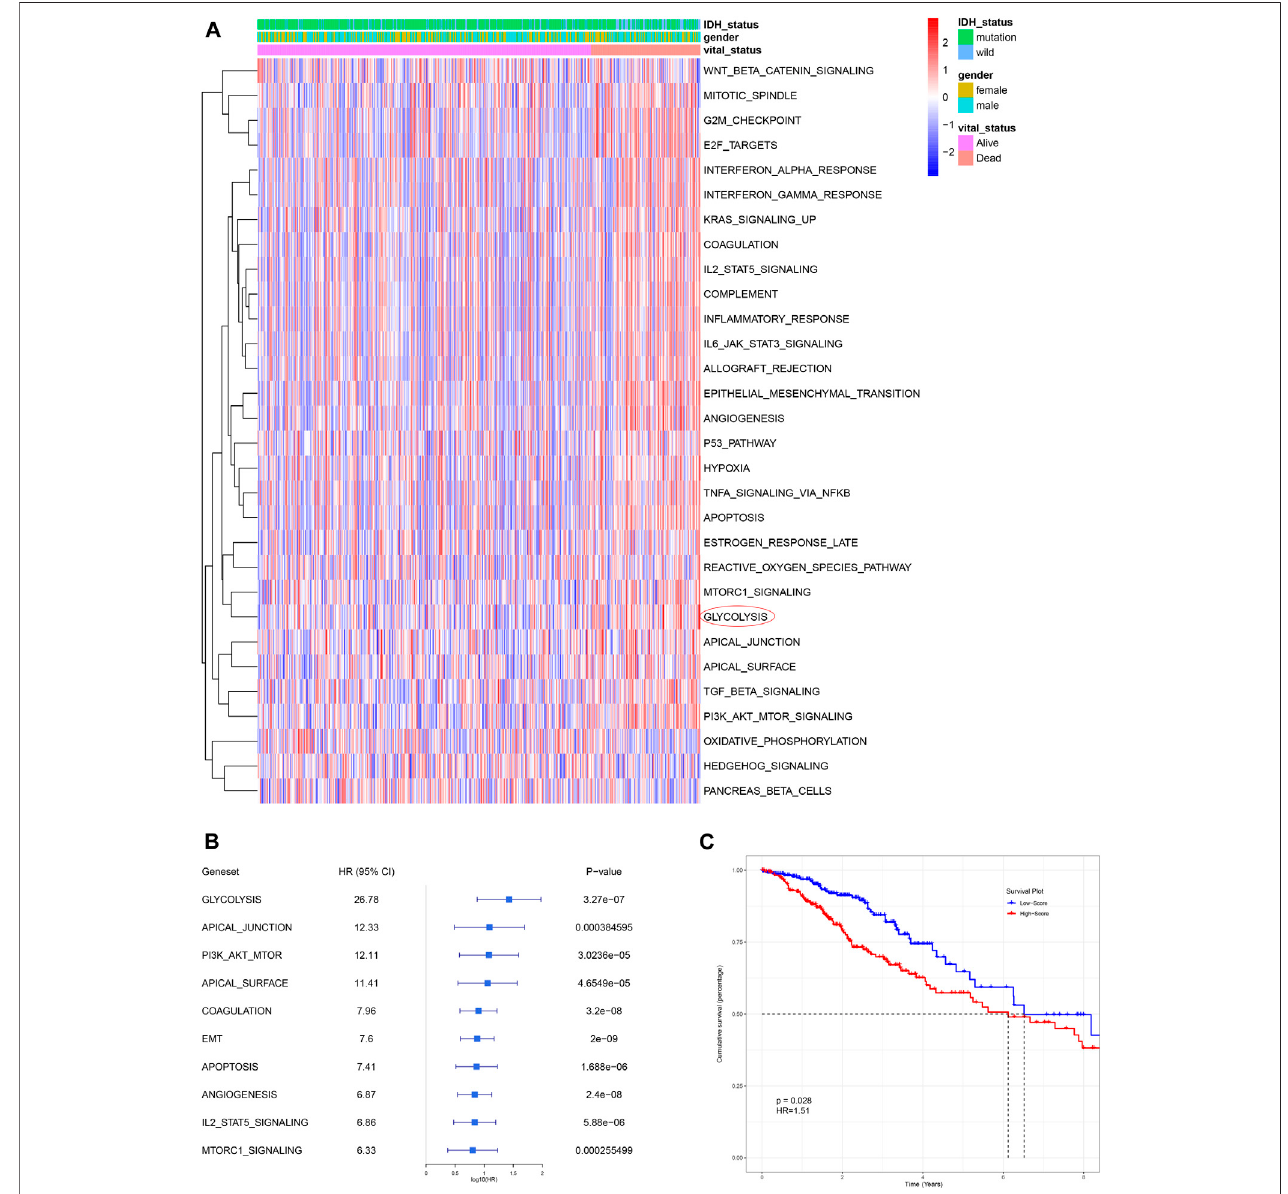
FIGURE 2 | Glycolysis was identi fi ed as the primary survival-related risk factor. (A) Heatmap for different hallmark pathway enrichment scores generated by the ssGSEA algorithm. (B) Univariate Cox analysis of top 10 hallmark pathways. (C) Patients with a higher glycolysis-associated ssGSEA score had a worse OS, as shown by Kaplan-Meier analysis. OS: overall